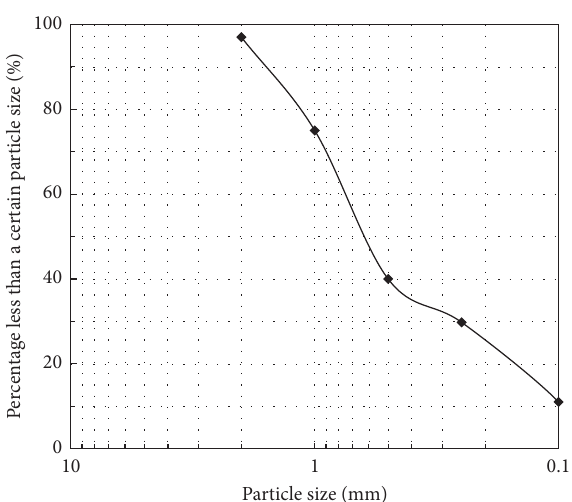
Figure 1: Grain size curve of Fujian standard